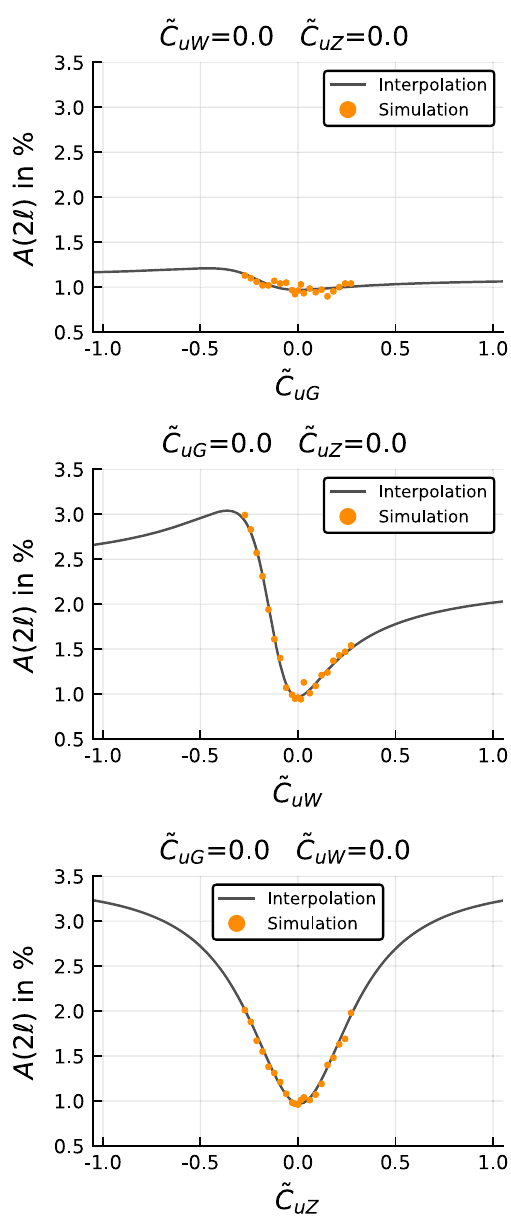
Fig. 12 Samplingpointsandinterpolationresultforthefiducialaccep- tance of the dilepton channel A ( 2 (cid:14)) , represented as slices of the phase space where only one of the Wilson coefficient is varied at a time, while the others are set to